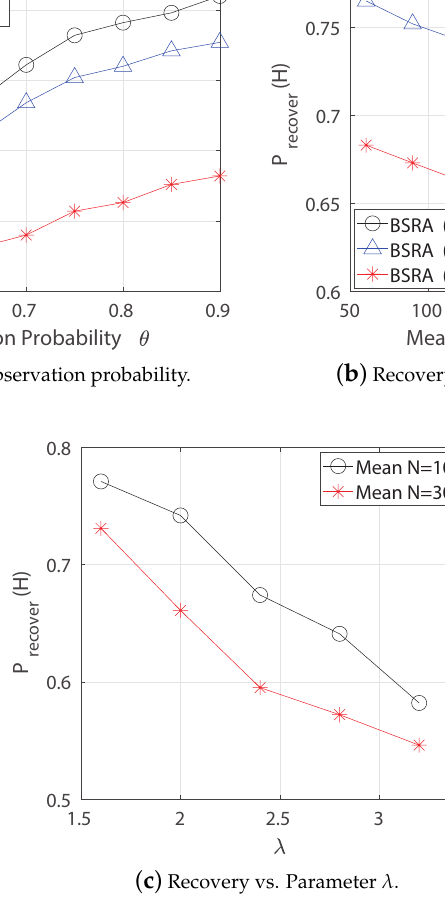
Figure 6. Recovery probabilities of NBRA( α ) for m = 3 and ζ = 3. (( a ) Recovery as the observation probability varies from 0.5 to 0.9. ( b ) Recovery by varying the mean number of infected nodes from 60 to 300. ( c ) Recovery as varying the parameter λ from 1.6 to